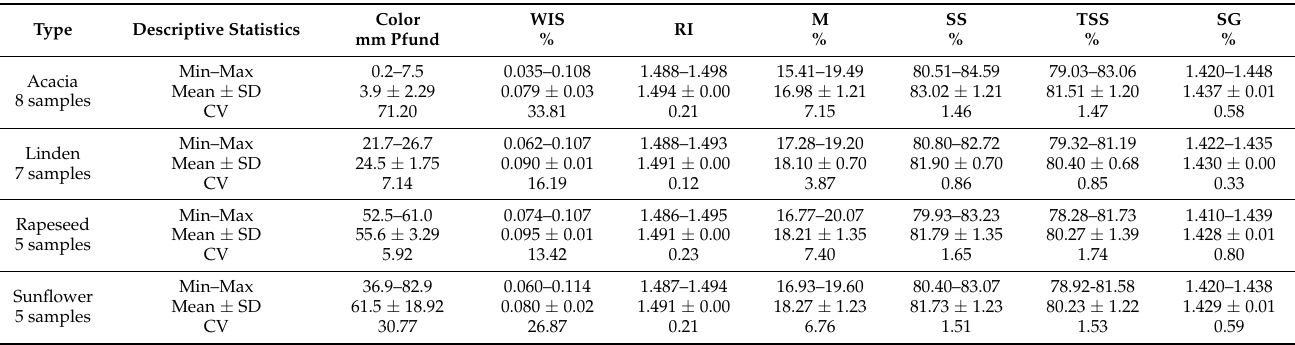
Table 1. Parameter (color, water-insoluble solids, refractive index, moisture, solid substances, total soluble solids, specific gravity) values of honey